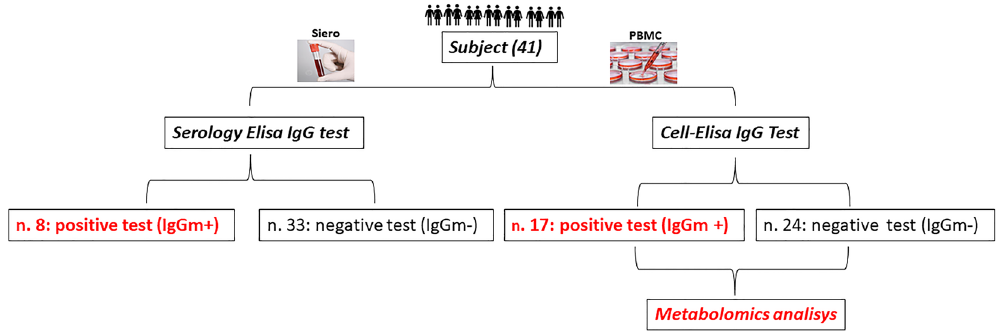
Figure 1. Clinical characteristics of the enrolled subjects. Samples were tested using both the ELISA serological test and In-Cell ELISA. In the first case, 8 subjects showed serological positivity; through In-Cell ELISA, we identified 17 positive samples for in vitro specific IgG secretion (IgGm + ). Therefore, 9 individuals who had negative ELISA serological test results were positive by In-Cell